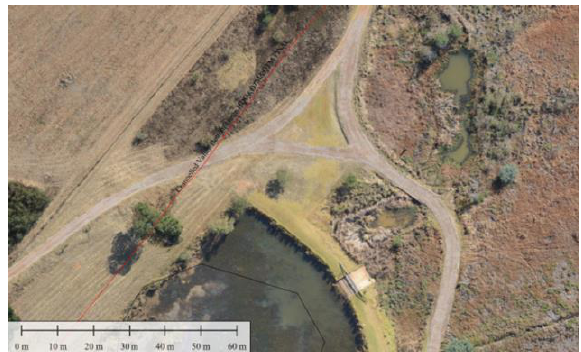
Figure 2. Estimation of disturbance classes from UAV orthophoto